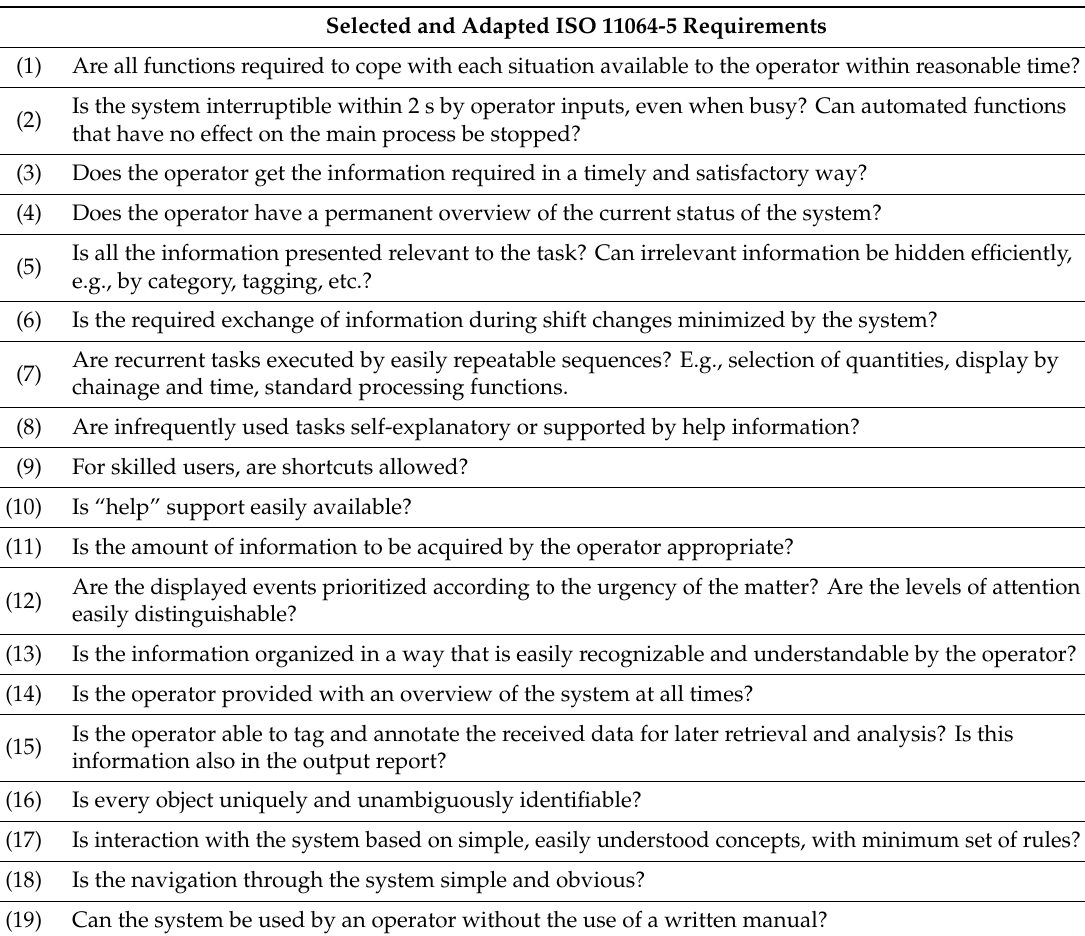
Table 2. Selected and adapted ISO 11064-5 requirements for SCMS